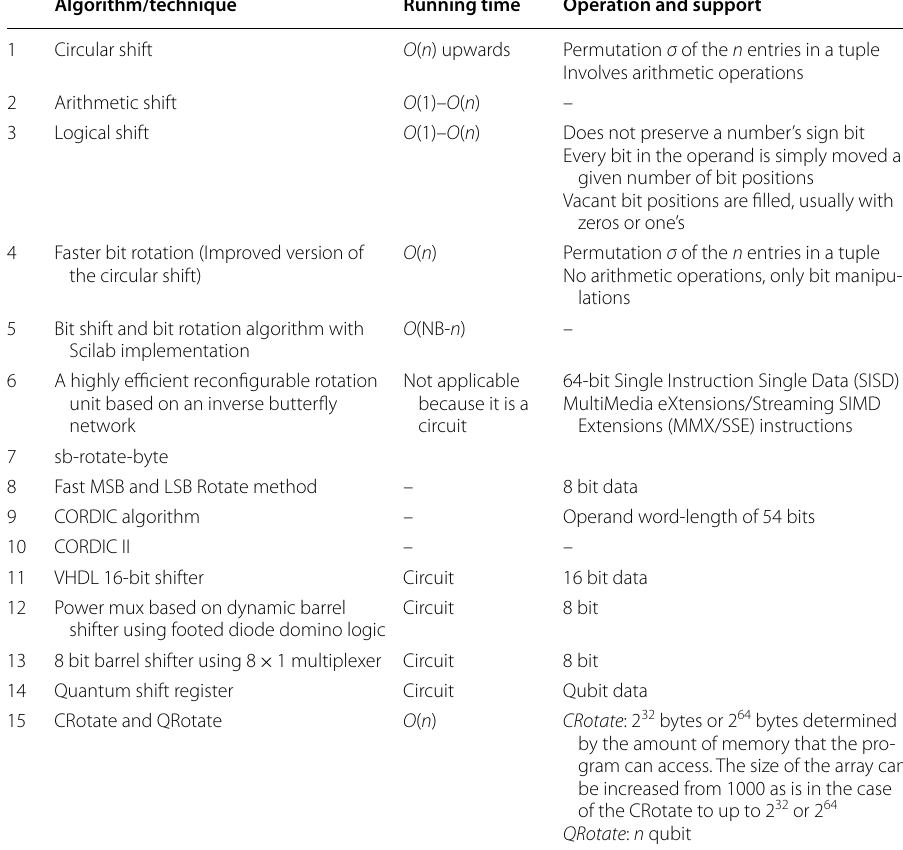
Table 1 Running time of bit rotation algorithms, techniques and circuits